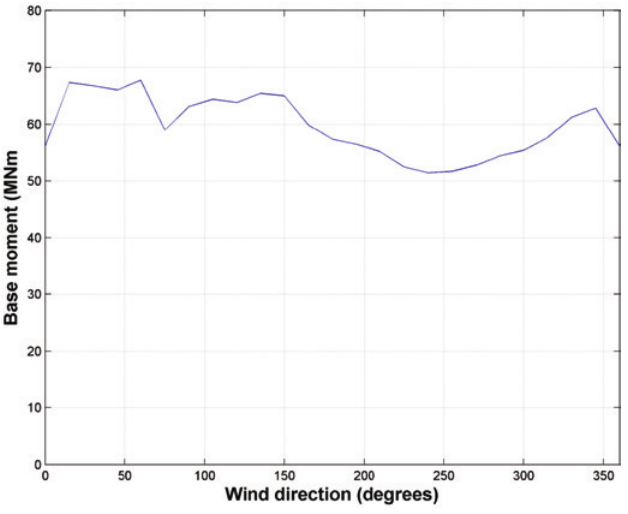
Figure 18 Moments at the base for the chimney with vicinity, with aerodynamic coefficients obtained from the wind tunnel. Observe worst case with incidence at 60